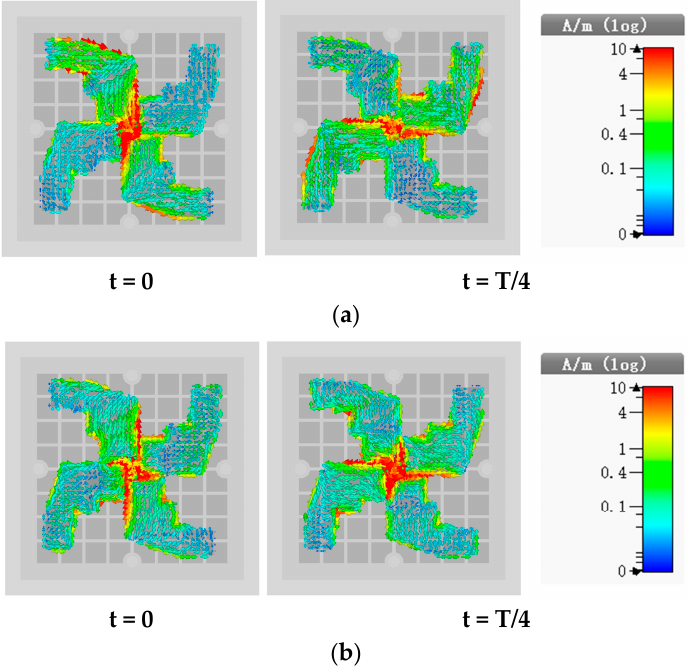
Figure 7. Current distributions on the crossed dipoles ( a ) 5.0 GHz, ( b ) 7.0